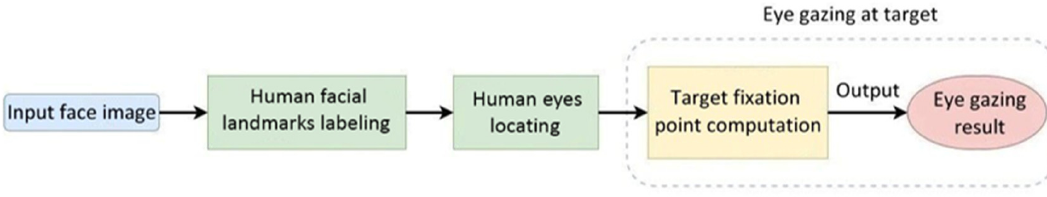
Figure 12. Flowchart of the eye gazing image recognition system used in care robots.